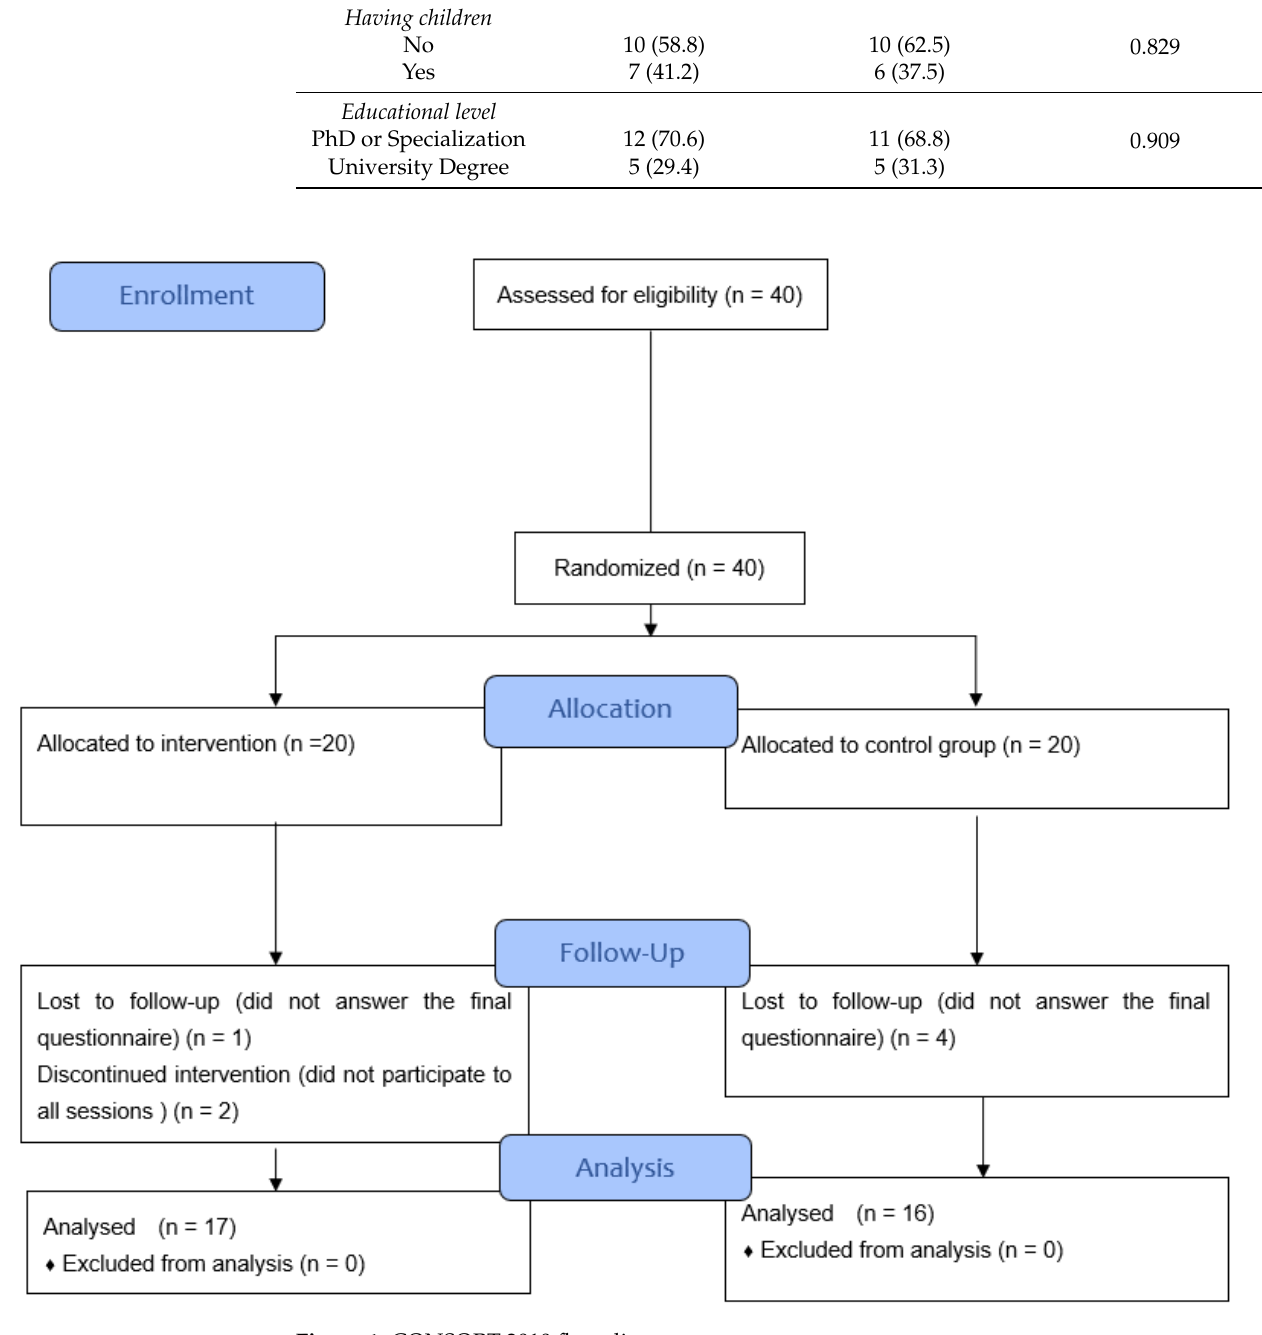
Figure 1. CONSORT 2010 flow diagram.